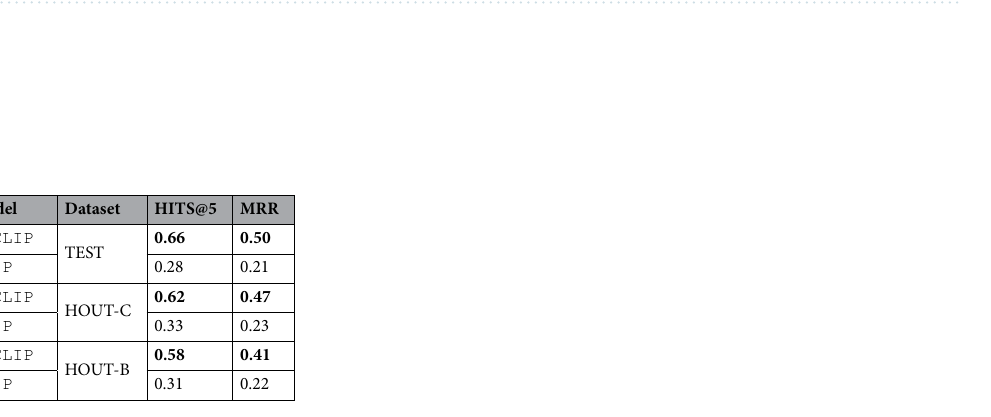
Table 1. Comparing FashionCLIP ( F-CLIP ) vs CLIP on the multi-modal retrieval task. Best performing models are in